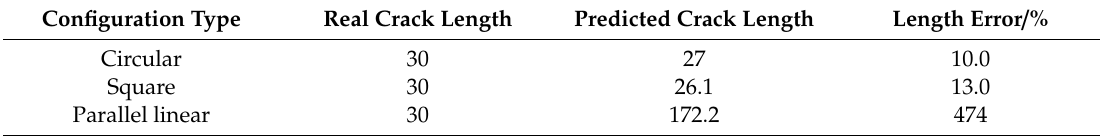
Figure 11. The improved images after SDC modification with three PZT sensor array configurations after a threshold value ( a ) The image with a circular array ( b ) The image with a square array ( c ) The image with a parallel linear array. Table 3. Evaluation of crack length with three PZT sensor array